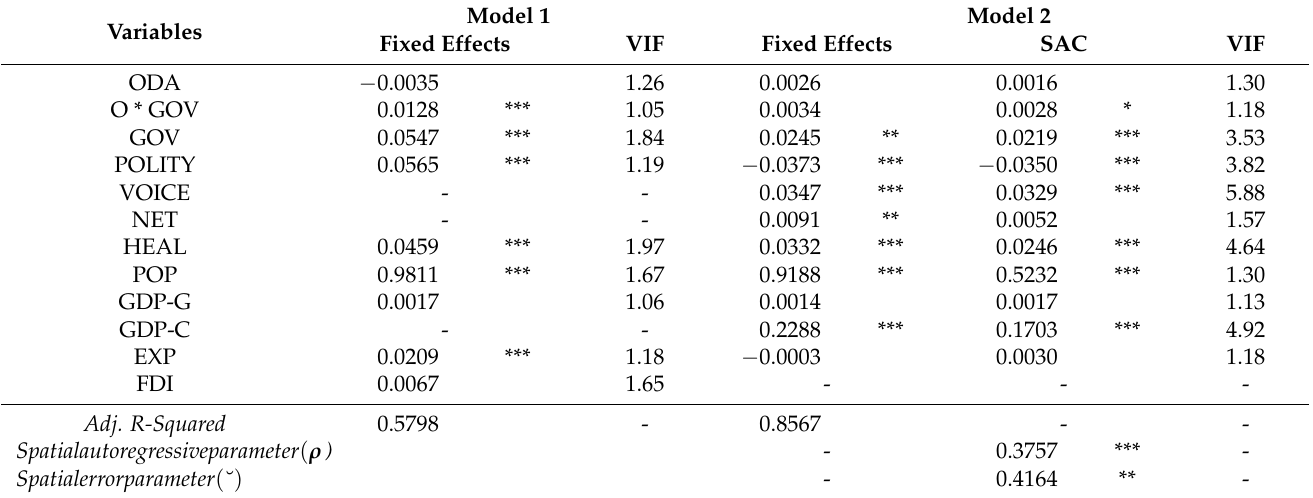
Table 3. Summary of regression